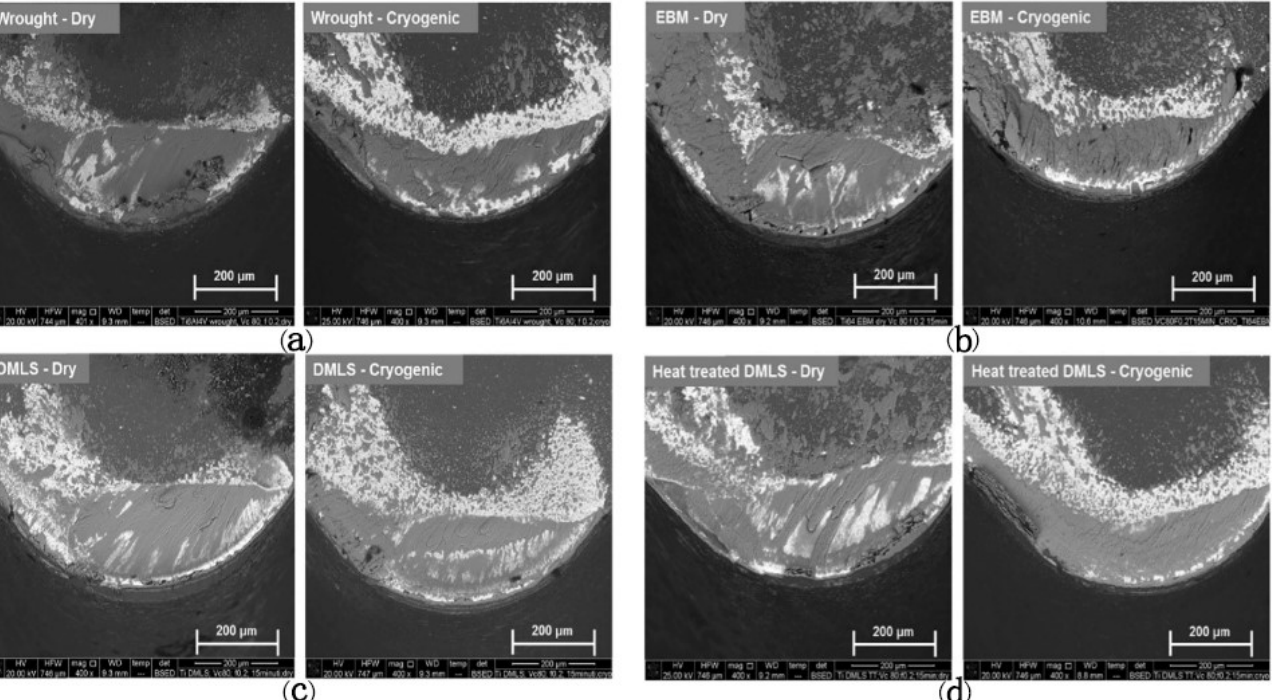
Figure 14. SEM images of worn tool rake faces after 15 min of turning under dry cutting and cryogenic cooling for different Ti-6Al-4V material: ( a ) wrought Ti–6Al–4V; ( b ) EBM Ti–6Al–4V; ( c ) DMLS Ti–6Al–4V; ( d ) Heat treated DMLS Ti–6Al–4V [119] (Reprinted with permission from [119]. Copyright 2017, Elsevier).